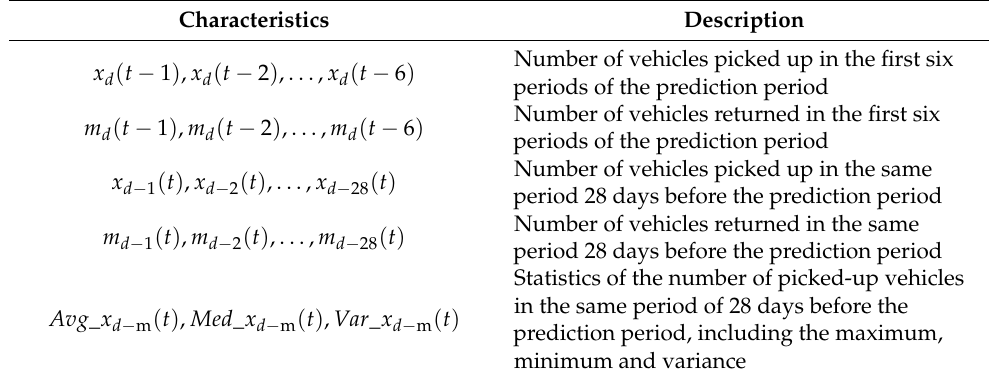
Table 4. Number of historical pick-ups and returns, and its time